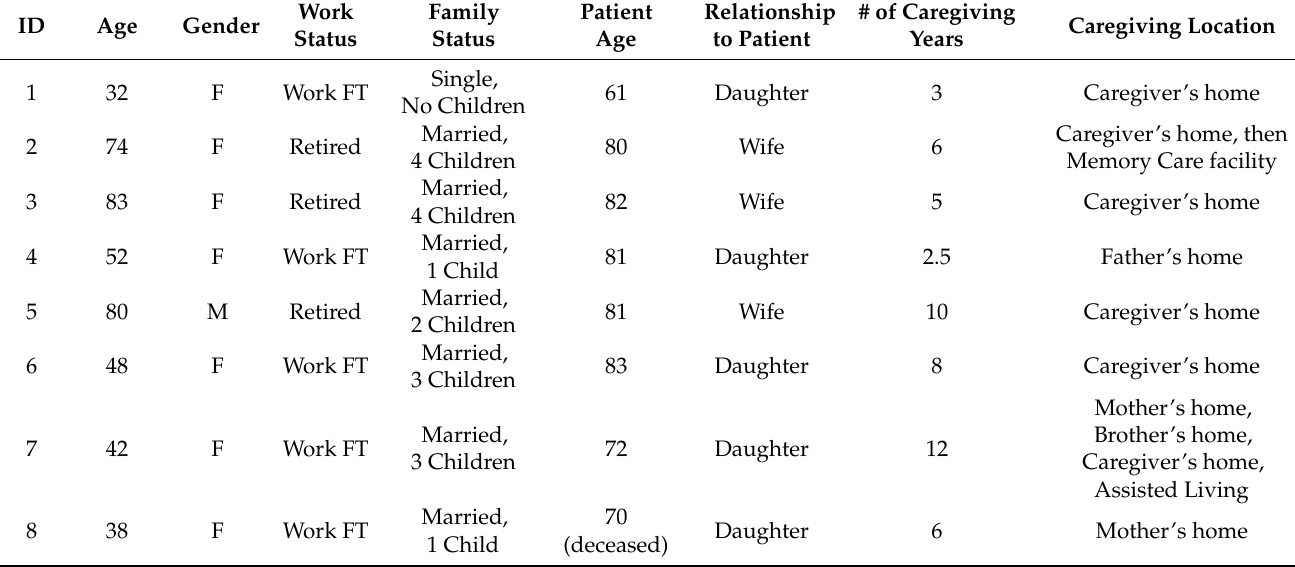
Table 2. Sociodemographic characteristics of